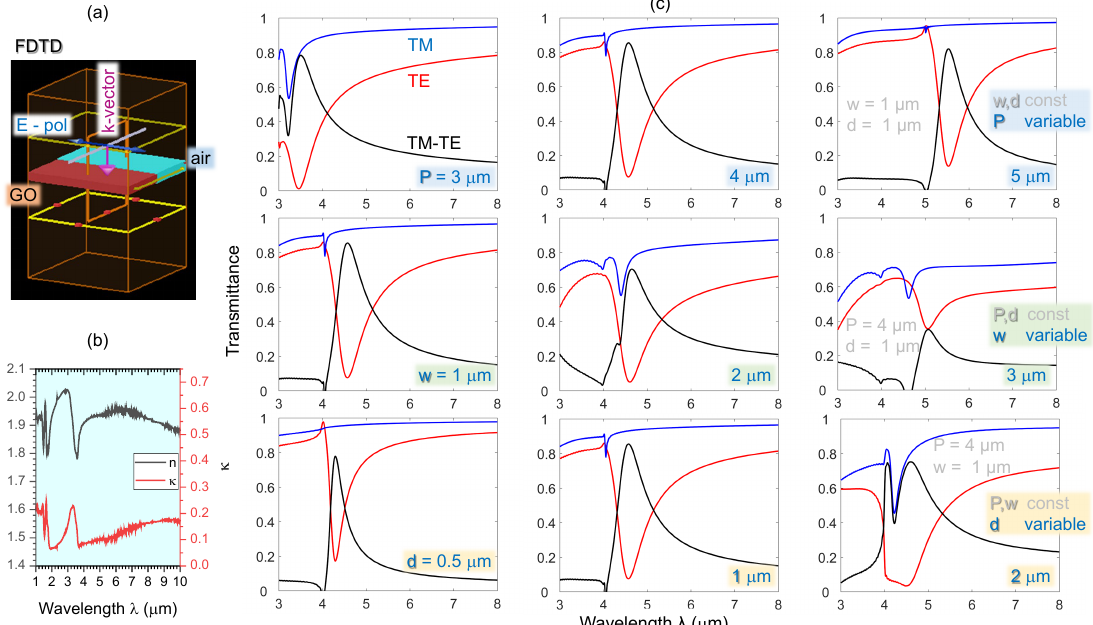
Figure 8. Numerical parameters P , w , and d for the study of the GO grating properties by FDTD. ( a ) FDTD model. ( b ) Index ( n , κ ) of GO used in the modelling (Lumerical database). ( c ) IR transmit- tance spectra from 3 to 8 µ m of the GO gratings with different parameters: ( top-row ) width w = 1 µ m and film thickness d = 1 µ m, while the grating period P changes from 3, 4, and 5 µ m, respectively; ( middle-row ) P = 4 µ m, and d = 1 µ m, while w is 1, 2, and 3 µ m, respectively; ( bottom-row ) P = 4 µ m and w = 1 µ m, while d is 0.5, 1, and 2 µ m,